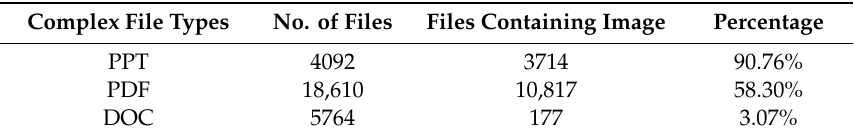
Table 8. Complex files that contain